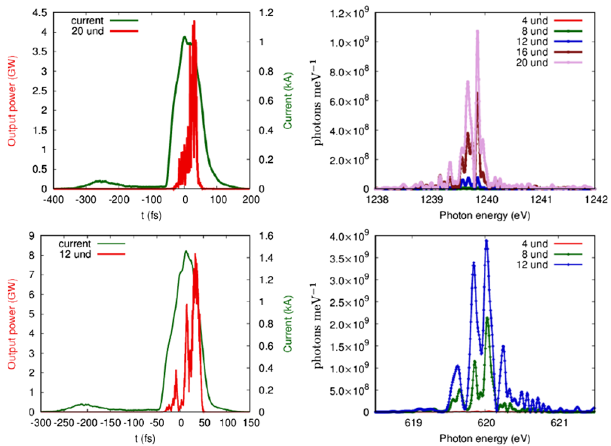
FIG. 13. EEHG x-rays at 1.2 keV (top) and 620 eV (bottom) with S2E e-beam. Power profiles overlaid with the final current profile (left) and spectra (right) at different positions along the radiating